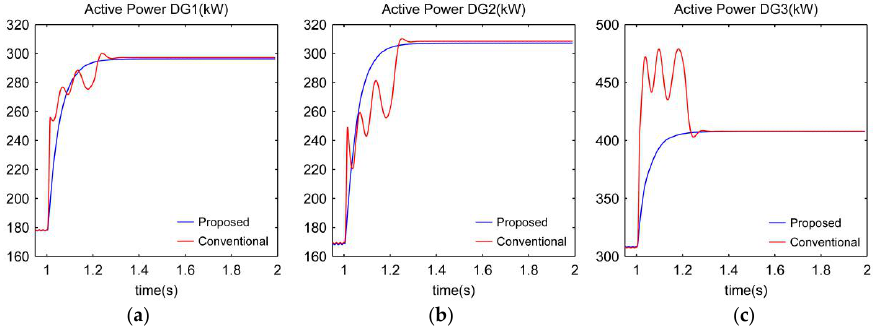
Figure 14. Voltage response of DG’s during islanding using proposed supplementary control